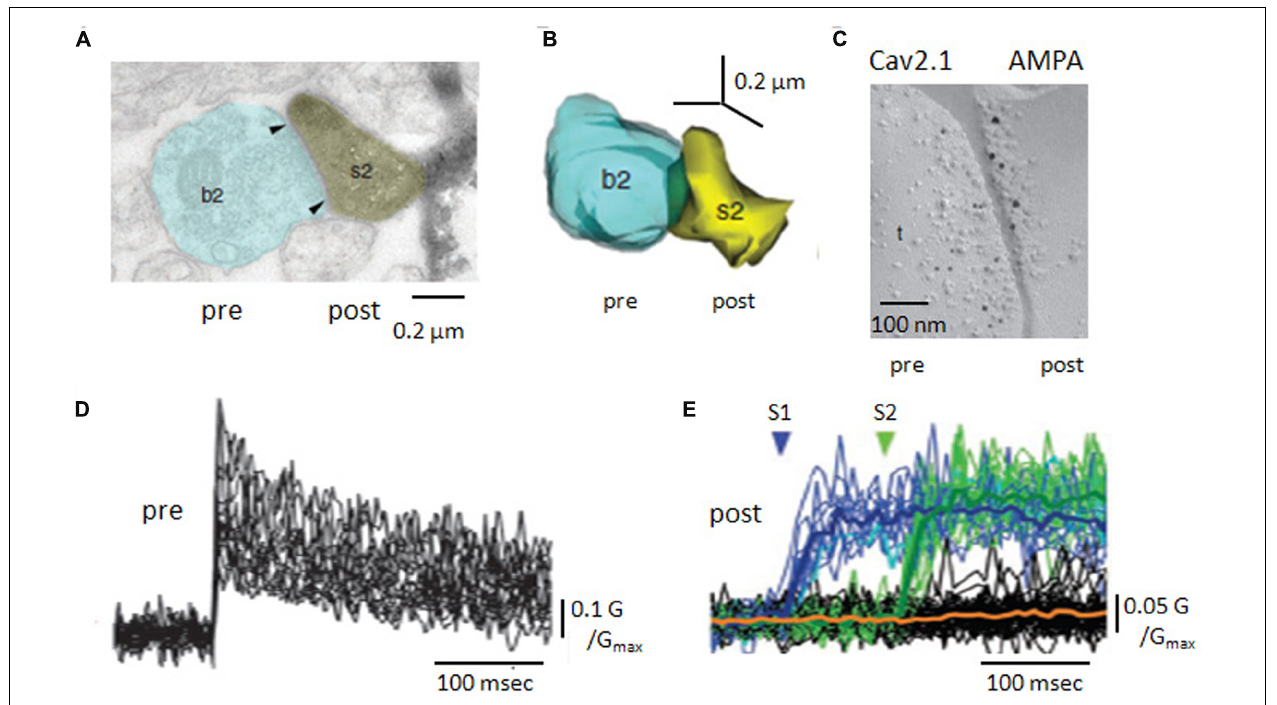
molecules (pre) and the larger gold particles recognize a pan-AMPA antibody (post). (D) Pre-synaptic Ca transients, measured as changes in fluorescent intensity, for 25 axon terminals of a CA3 pyramidal cell. (E) Post-synaptic Ca transients, in response to two pre-synaptic stimuli. Note the occurrence of failures in both post-synaptic responses but their absence from pre-synaptic signals (adapted with permission from Holderith etal.,